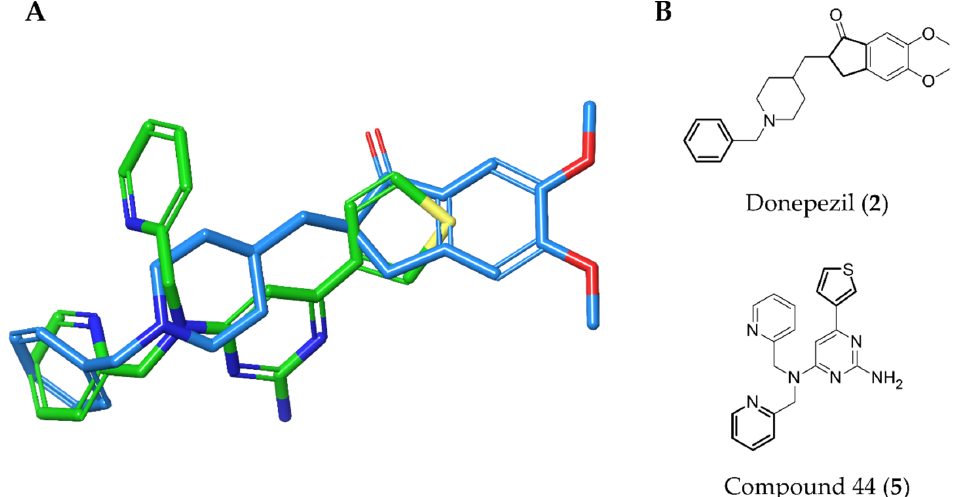
Figure 3. ( A ) Superposition of reference ligands in their bioactive, co-crystallized conformations. AChE inhibitor Donepezil from PDB 4EY7 is shown in blue and α 7 nAChR agonist Compound 44 from PDB 5J5F in green. Atoms of the rings shown in bold in Panel B were used for superimposition of the ligands. ( B ) Chemical structures of Donepezil and Compound 44.